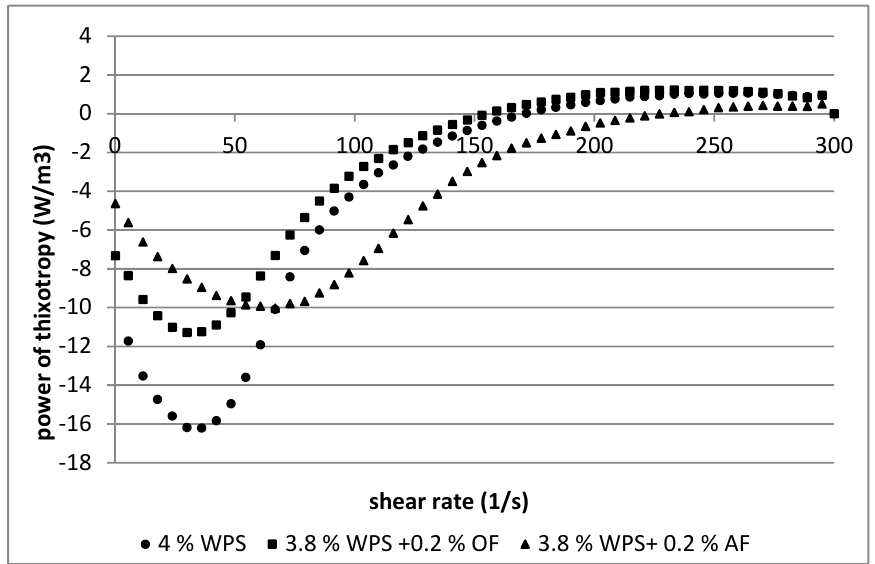
Figure 6. Relationship between the power of thixotropy in a volume of the sample at a defined shear rate and the shear rate in 4% ( w / w ) starch pastes and its 4% mixtures (3.8% starch with 0.2% dietary fibers). Waxy potato starch (WPS), oat fiber (OF), apple fiber (AF).